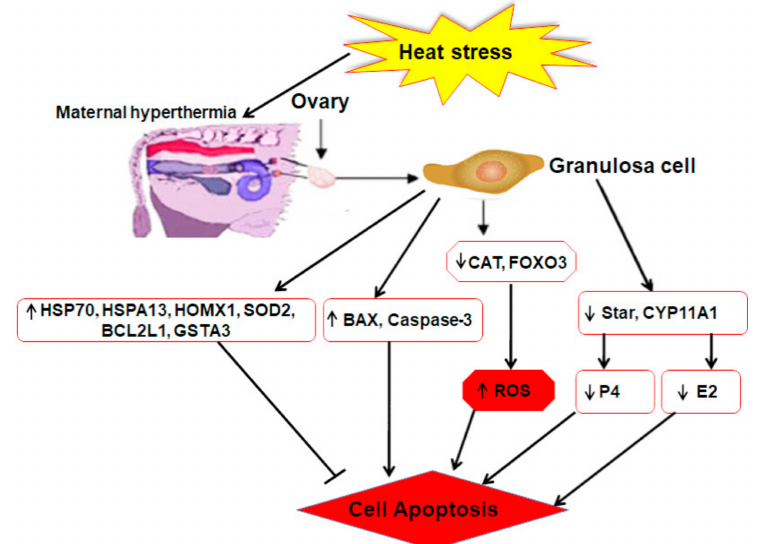
Figure 4. Mechanisms of regulating heat stress response related to follicular function within bovine ovary. Upregulated genes caspase-3, superoxide dismutase (SOD), BCL-2 , and BAX , and heat shock proteins (HSPs) (HSP70, HSPA13, HMOX1) are involved in the regulating mechanism of bovine GCs via induced or inhibited cell apoptosis. Under heat stress, downregulated genes CAT and fork head box O3 (FOXO3) were involved in the production of reactive oxygen species (ROS). Likewise, downregulation of steroidogenic acute regulatory protein (STAR) and cytochrome P450, family 11, subfamily A, polypeptide 1 ( CYP11A1 ) were involved in the secretion of E2 and progesterone (P4). Moreover, the decline of E2 and the enhancement of ROS might, in turn, enhance the possibility of GC apoptosis and follicle